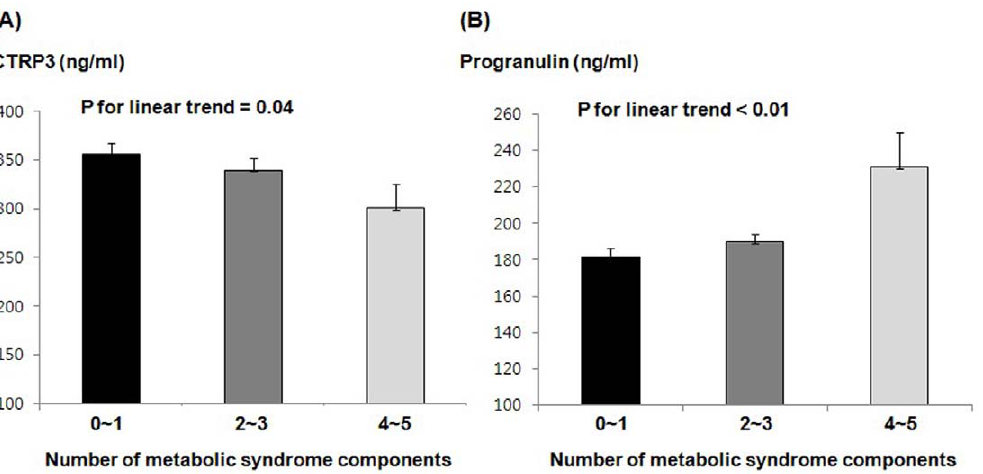
Figure 1. Serum C1q/TNF-related Protein-3 (CTRP3) (A) and Progranulin Levels (B) According to Number of Metabolic Syndrome Components.